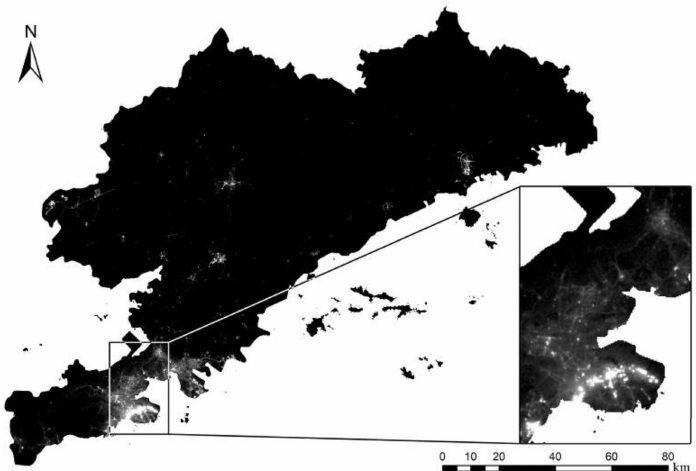
Figure 7. Preprocessed remote sensing data of night light in